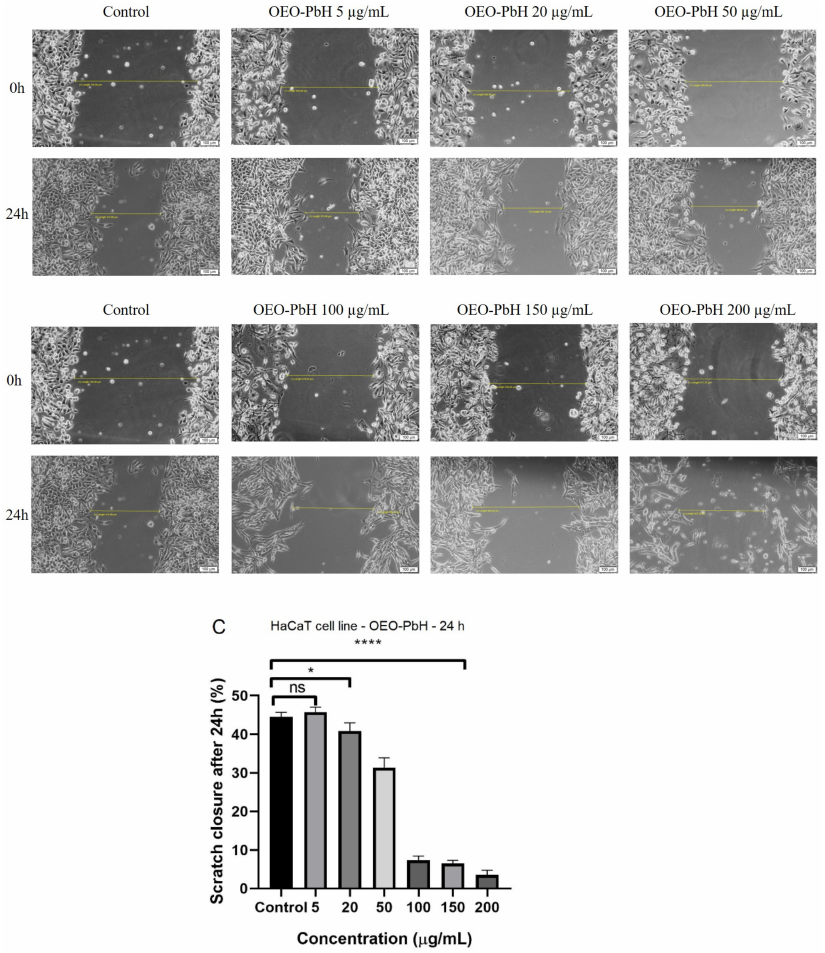
Figure 5. OEO-PbH ( A ) (5, 20, and 50 µ g/mL) and ( B ) (100, 150, and 200 µ g/mL) effect on HaCaT human keratinocytes migration and proliferation potential. ( C ) Scratch closure rate after 24